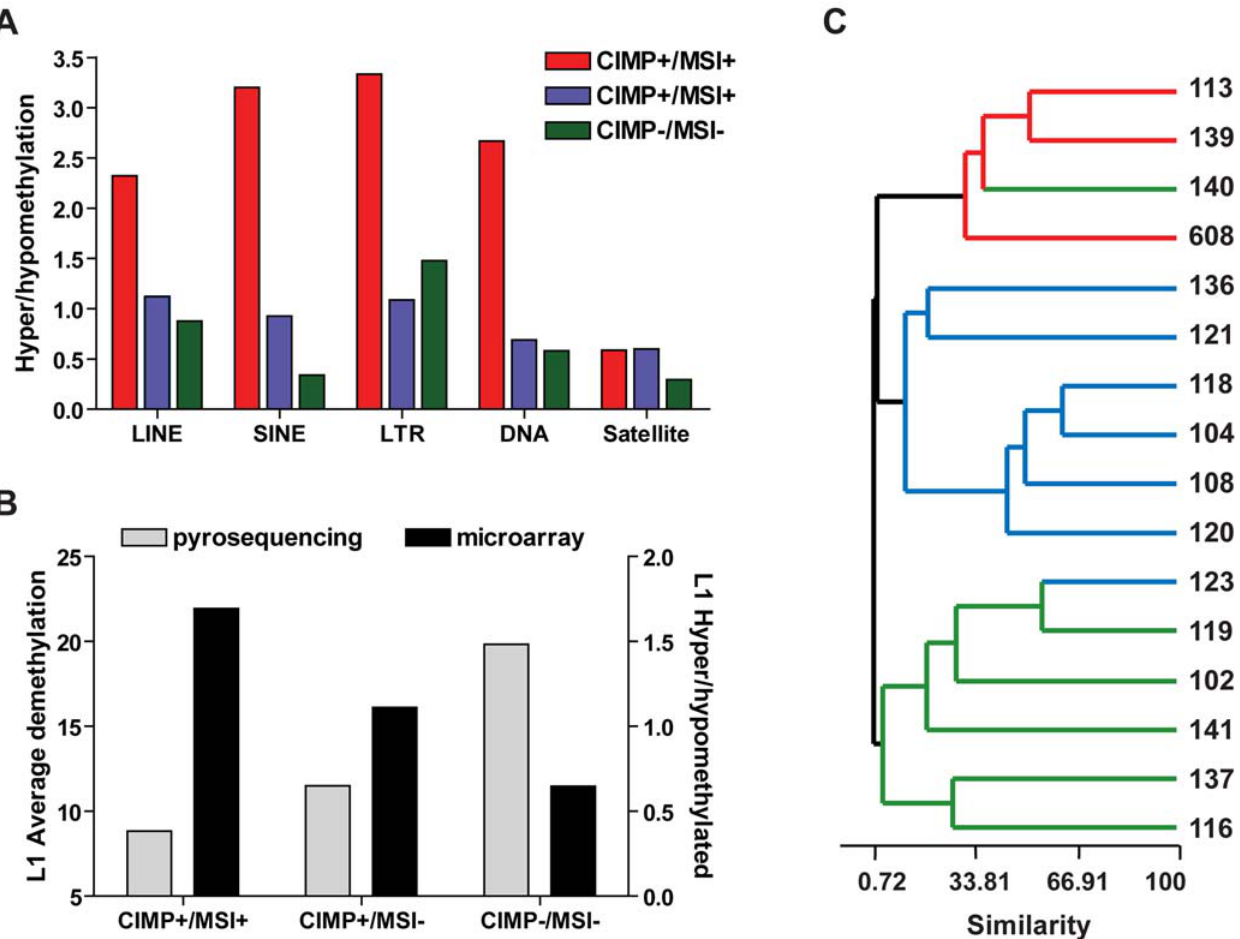
Figure 3. Methylated CpG Island Amplication (MCA)/CpG island microarray for repetitive DNA sequences. A) Relative abundance of hypermethylated and hypomethylated repeats for each CIMP/MSI group. A higher number of hypermethylated compared to hypomethylated repeats was observed for the CIMP + /MSI + group, and a gradual change in representation of hypermethylated and hypomethylated repeats was seen for the CIMP + /MSI-and CIMP-/MSI-groups, resulting in an overrepresentation of hypomethylated repeats in microsatellite stable groups. B) Validation of microarray results for LINE repeats. Note that CIMP/MSI groups with higher demethylation, as determined by bisulfite-pyrosequencing of LINE-1, presented also a higher number of hypomethylated LINE repeats by microarray analysis, as represented by a lower hyper/hypomethylation ratio. C) Unsupervised hierarchical clustering was applied to methylation data from a set of 770 repetitive DNA sequences across sixteen colorectal tumors paired with their normal appearing mucosa DNA. The colorectal tumors dendrogram is shown, and the sample ID for each case is included in the right. The terminal branches are color coded to represent the CIMP/MSI status of the tumor sample (red, CIMP + /MSI + ; blue, CIMP + /MSI-; green, CIMP-/MSI-). Overall, samples of the same CIMP/MSI group clustered together, reinforcing the different methylation fate for repetitive DNA sequences methylation in each group. LINE, long interspersed nuclear elements; SINE, short interspersed nuclear elements, LTR, long terminal repeats; DNA repeats; Satellite repeats.